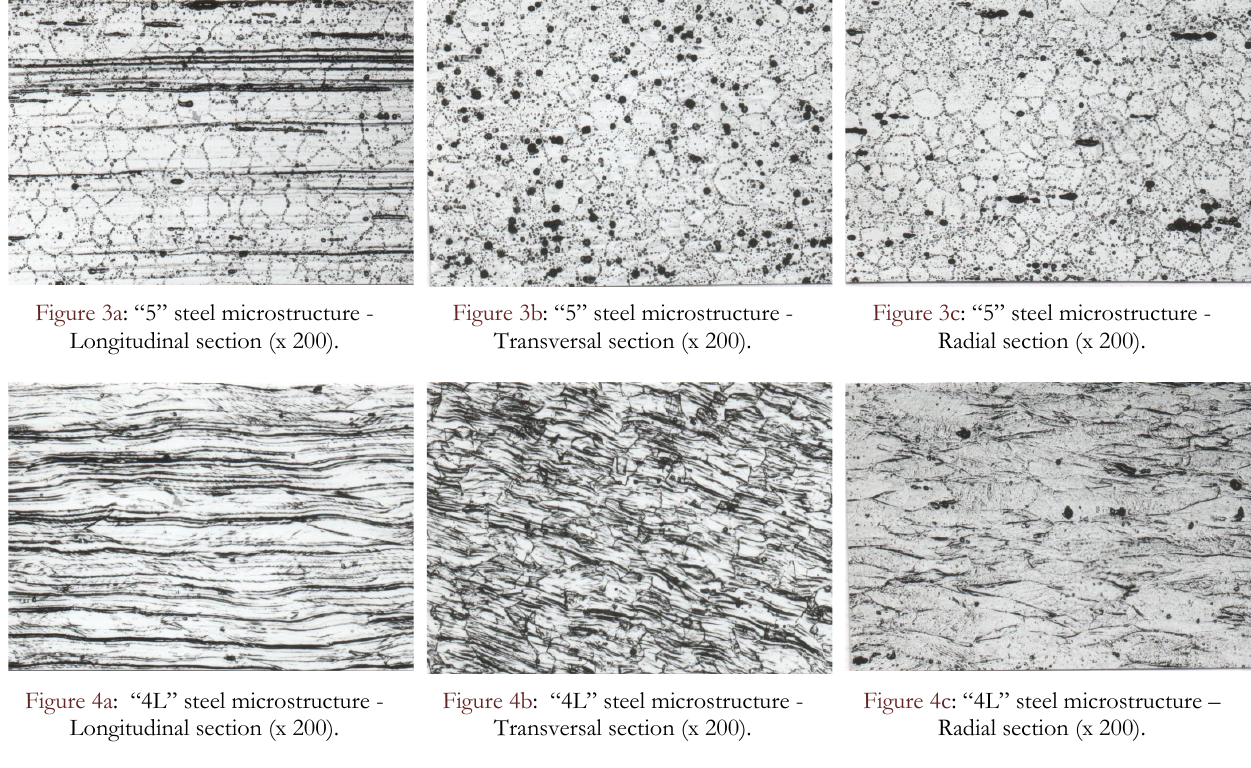
Figure 4b: “4L” steel microstructure - Transversal section (x 200).